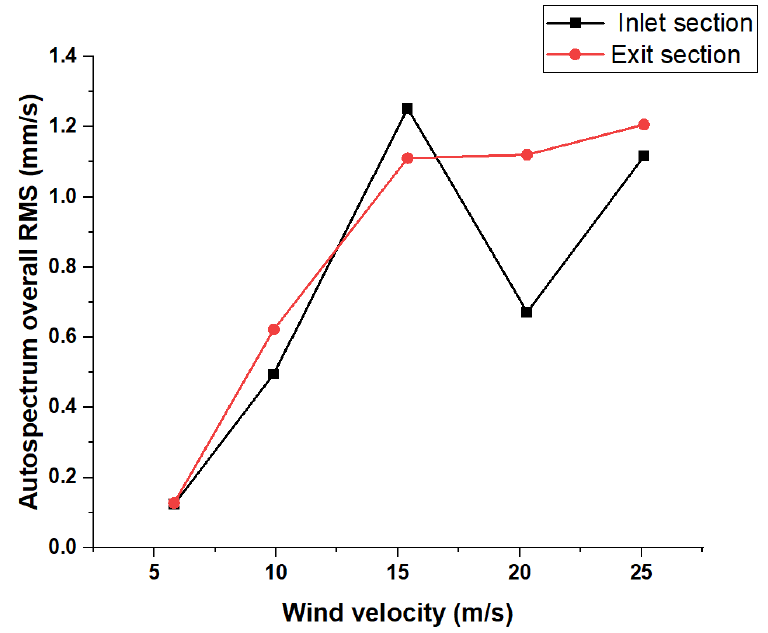
Figure 15. The vibration amplitude fluctuation versus the wind velocity.